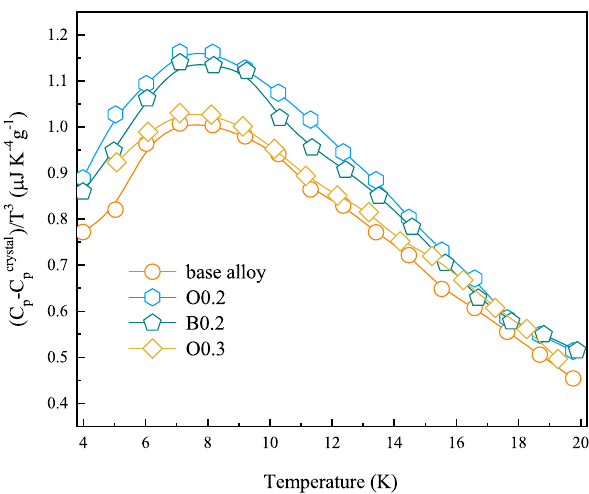
Fig. 3 Experimental data of low-temperature speci fi c heat capacity of the base alloy, and of the doped alloys O0.2, B0.2, and O0.3. ( C p − C p crystal )/ T 3 vs T , in which the heat capacity of the crystallized counterpart ( C of the as-cast amorphous sample was subtracted from that of the glassy sample ( C p ). Alloys O0.2 and B0.2 show higher boson peak intensity, as compared with the base alloy, indicating a state of enhanced structural heterogeneity.